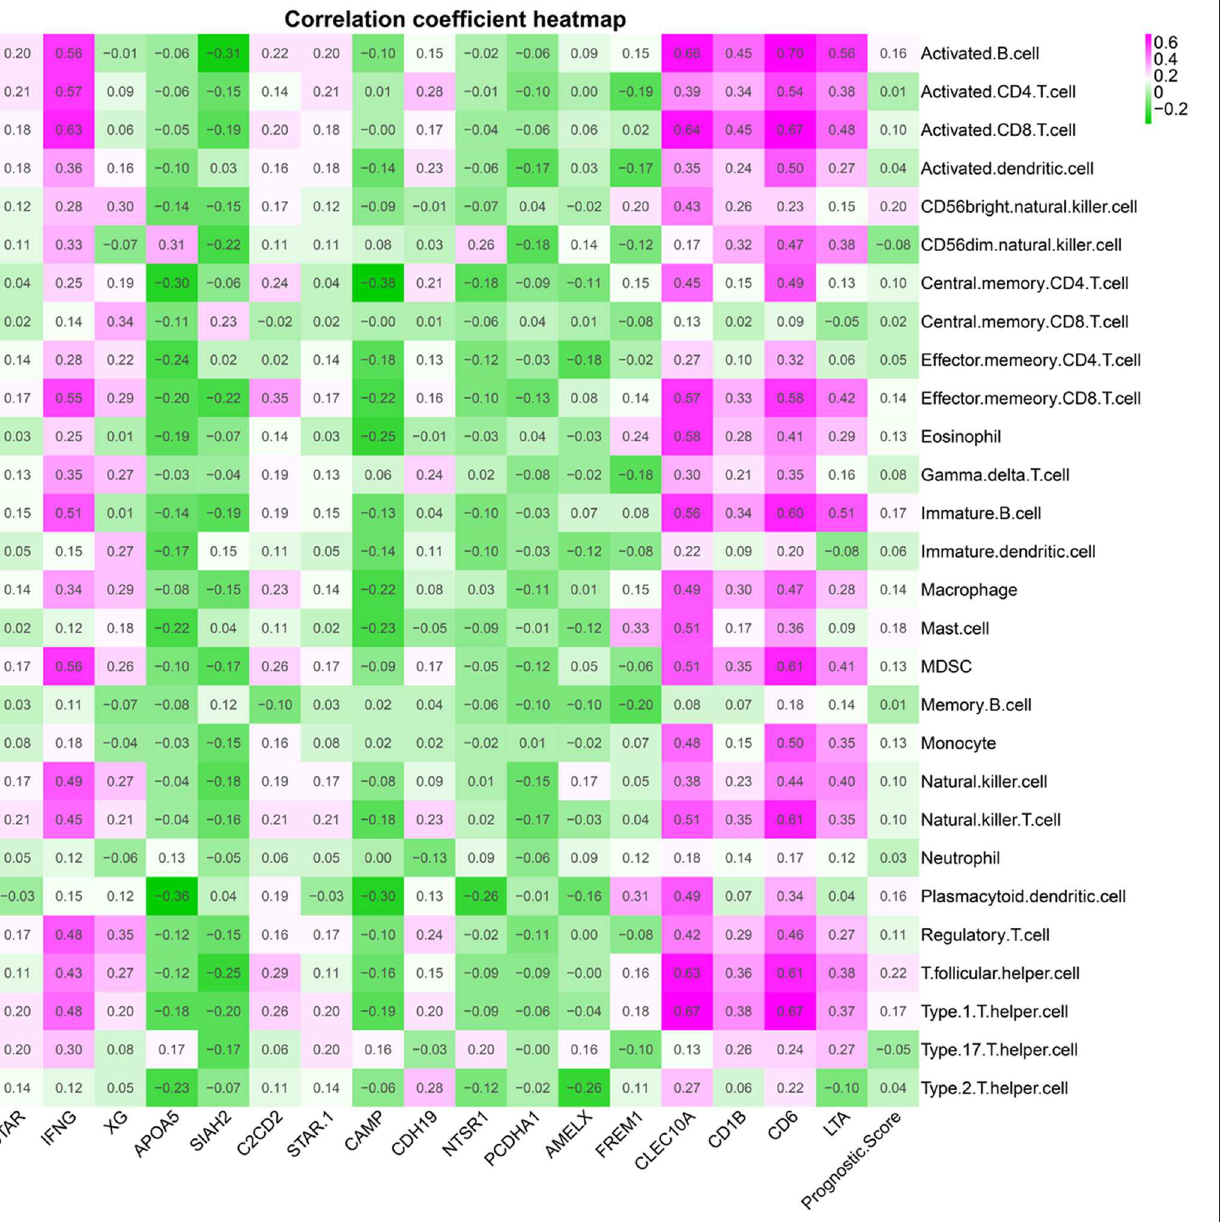
FIGURE 10 | Immune gene correlation coefficient